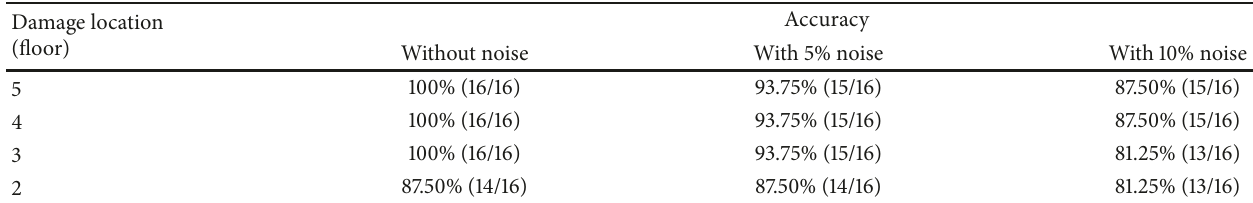
Table 7: Detection accuracy of identified damage locations based on PC and